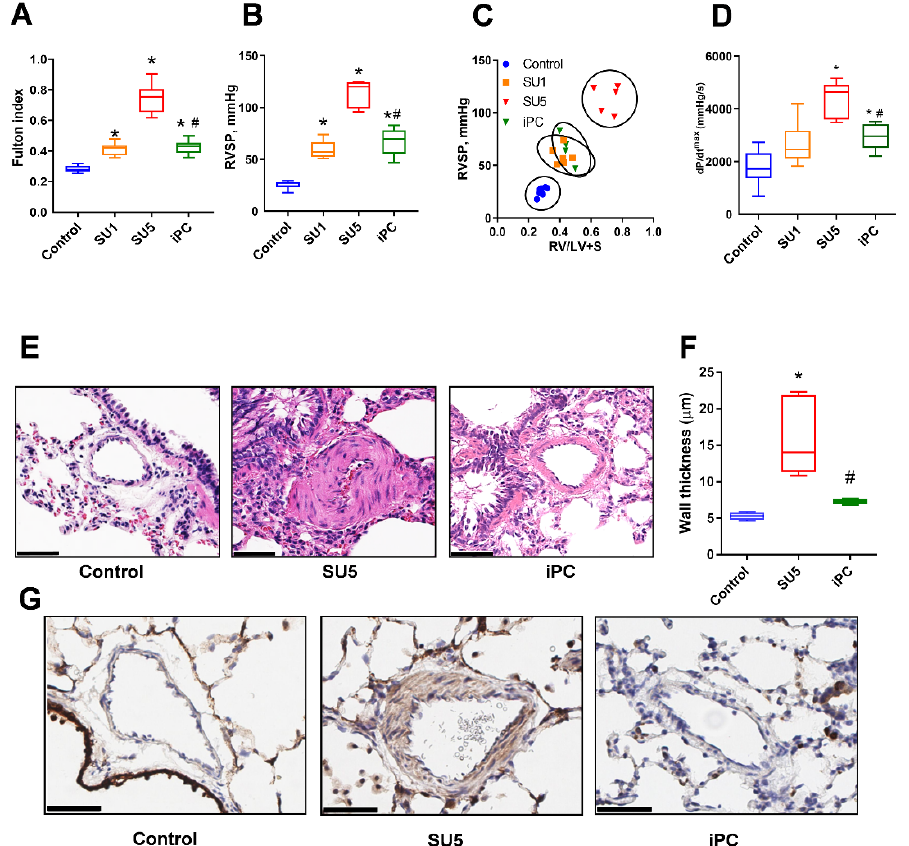
Figure 1. Pyruvate carboxylase (PC) inhibitor reduced hemodynamic and pathological changes in Sugen5416 treatment with three-week hypoxia followed by 2 week normoxia (SU5) rats and prevented pulmonary arterial hypertension (PAH) pathogenesis. ( A ) Right ventricular systolic pressure (RVSP) was significantly increased in SU5416 treatment with one-week hypoxia (SU1) and SU5 groups but PC inhibitor (iPC) treatment in SU5 groups controlled further increase in right ventricular (RV) pressure. ( B ) Fulton index, the ratio of RV to left ventricle and septum (RV / (LV + S)), was significantly increased in SU1 and SU5 groups and PC inhibitor treatment prevented its further increase from SU1 level. ( C ) Correlation analysis between RVSP and Fulton index showed a significant attenuation of the PAH phenotype in SU5 rats treated with the PC inhibitor. ( D ) SU5 groups showed increased dP / dtmax, but PC inhibitor significantly improved cardiac function and attenuated dP / dtmax. ( E ) hematoxylin and eosin (H&E) staining exhibited vascular fibrosis, constriction of pulmonary arteries (PA), and vascular proliferation in SU5 and these alterations were significantly attenuated with PC inhibitor treatment (scale–50 µ m). ( F ) PA wall thickness was found to increase in the SU5 group, PC inhibitor treatment protected from the additional vascular remodeling. ( G ) Ki-67 immunohistochemical staining showed increased cellular proliferation in the media of the pulmonary artery in the SU5 group and PC inhibitor e ff ectively prevented vascular remodeling and cellular proliferation (scale–50 µ m). ( A , B , D , F ) expressed as box-and-whisker plot with median value ± min max, N = 5–6, * p < 0.05 versus control, # p < 0.05 versus SU5 by